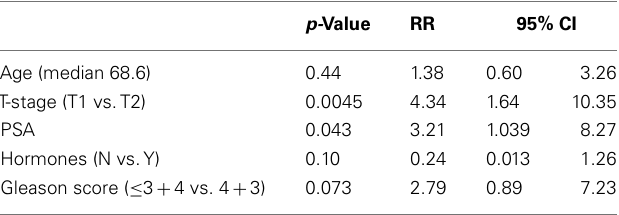
Table 2 | Relative risk and p -value from Cox regression multivariable analysis for pretreatment predictors of biochemical failure . p- Value